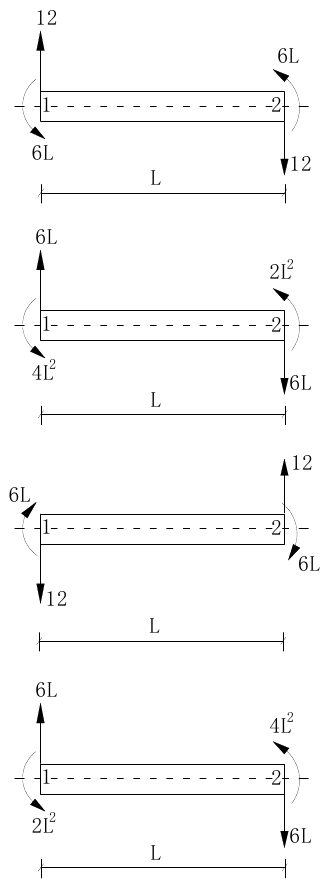
Figure 2. Load configurations of the four characteristic forces.